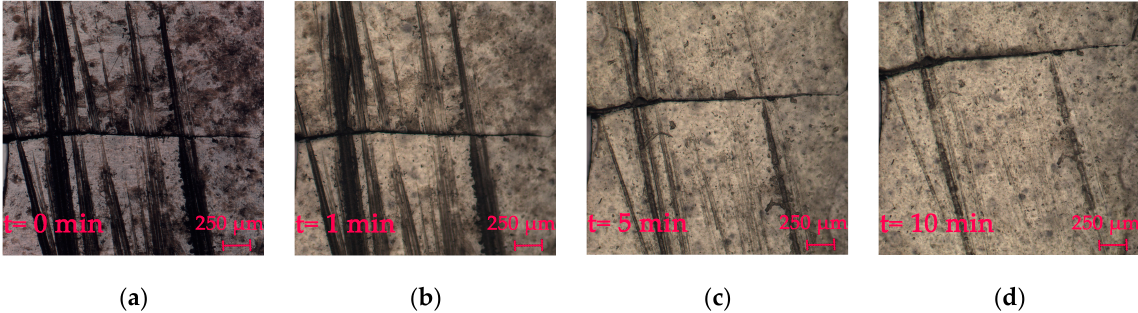
Figure 8. Optical microscopic images of healing accelerated by HCl of copolymer 1 (AAm/AAc =